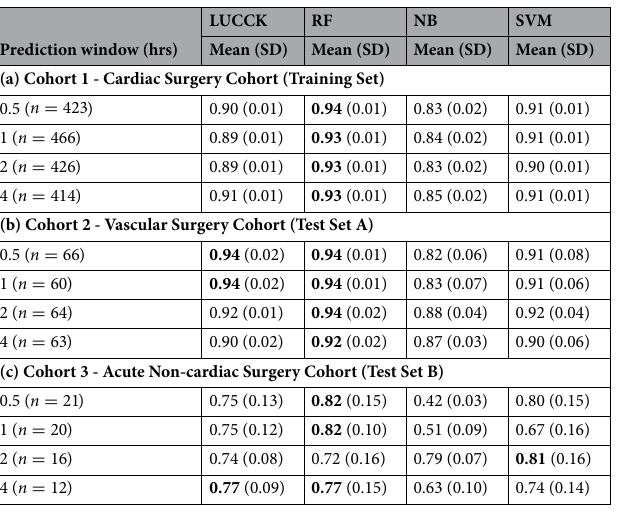
Table 4. Mean AUROC and standard deviation of the models. The means and standard deviations (SDs) of AUROC for models trained on the Cohort 1 (Cardiac Surgery) and tested on Cohorts 2 (Vascular Surgery) and 3 (Acute Non-cardiac Surgery). The n in each row represents the number of deterioration events (i.e., the sample size). The best performance in each prediction window is boldfaced.